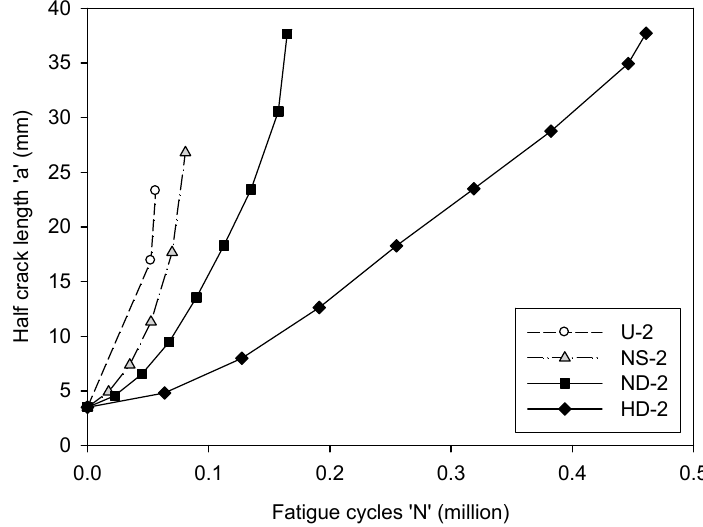
Figure 7. Crack length versus fatigue cycles.